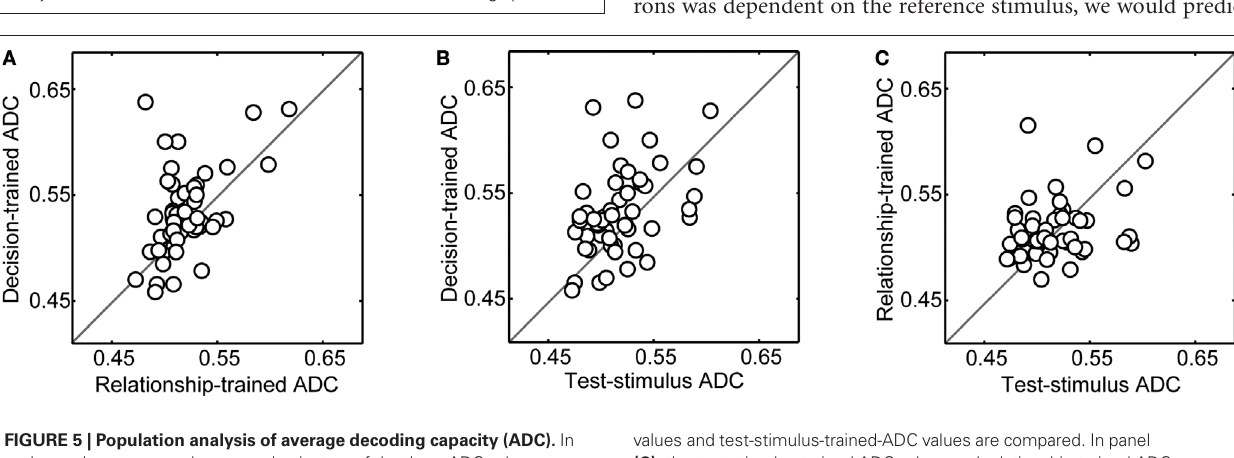
values and test-stimulus-trained-ADC values are compared. In panel (C) , the test-stimulus-trained-ADC values and relationship-trained-ADC values are compared. In each panel, the solid line is the line of equal ADC value.